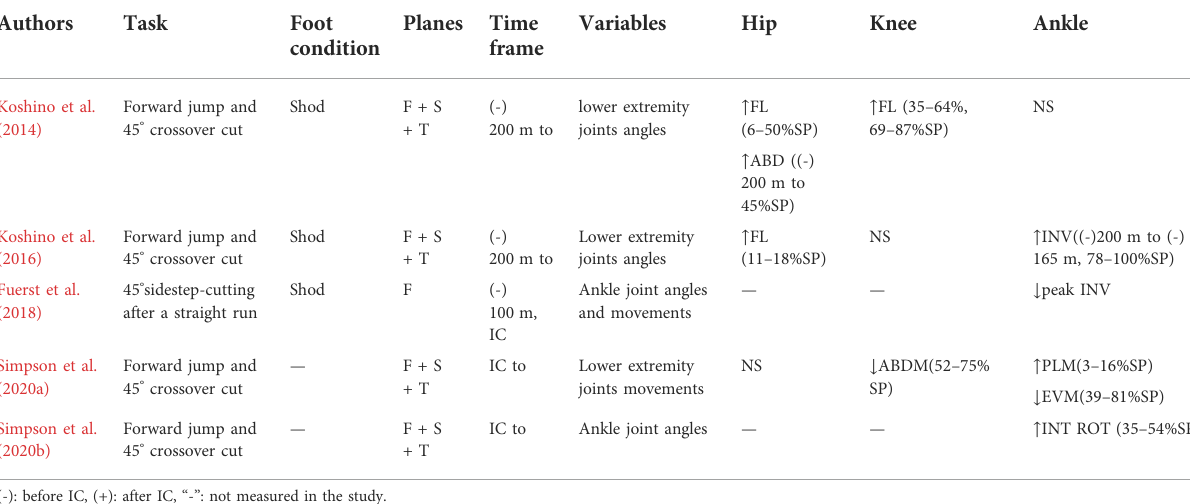
TABLE 2 Summary of articles related to side cut.